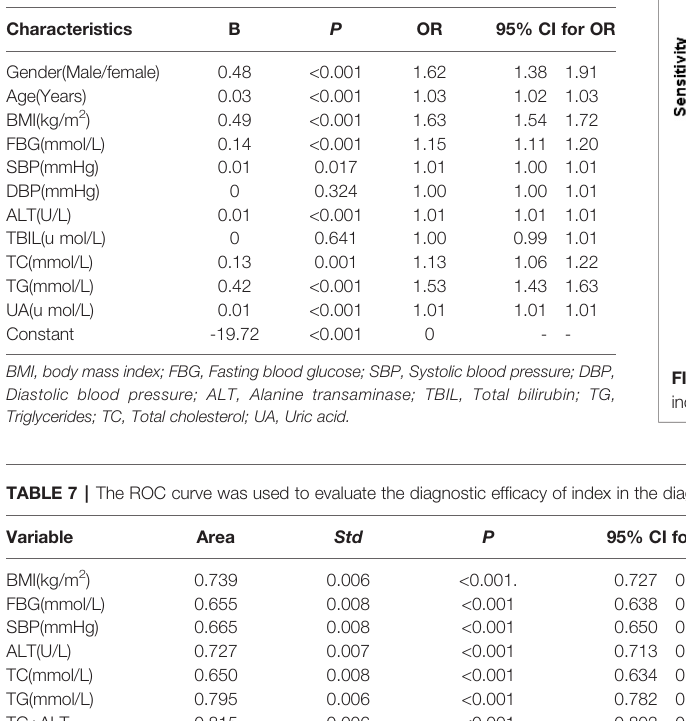
TABLE 6 | Logistic regression analysis of non-obese fatty liver disease in 2016 non-obese physical examination subjects. Characteristics